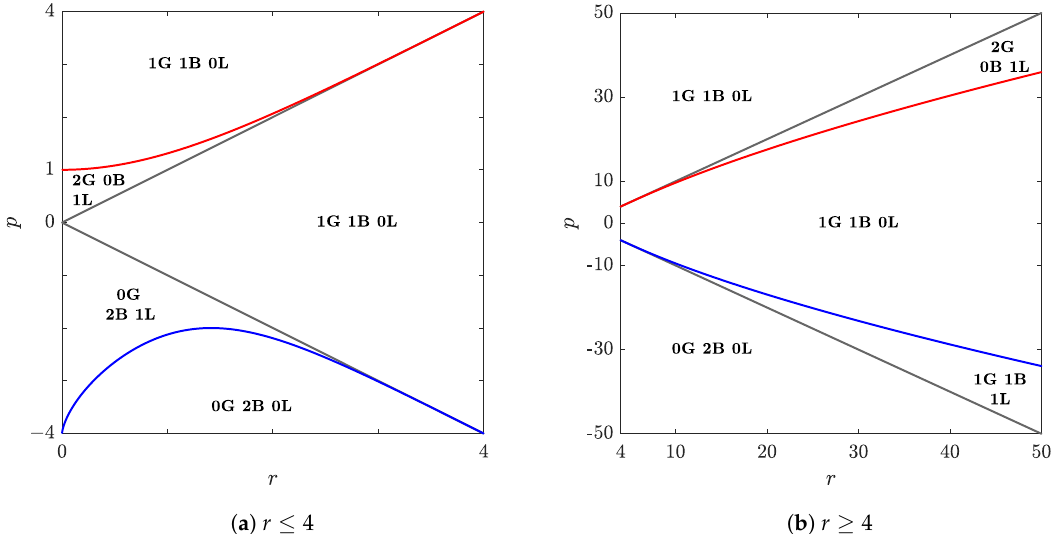
Figure 1. The number of gaps (G), branches (B) and loops (L) of each of the five types of spectra S x in the ( r , p ) plane. The two straight lines p = ± r and the red and blue curves are the threshold